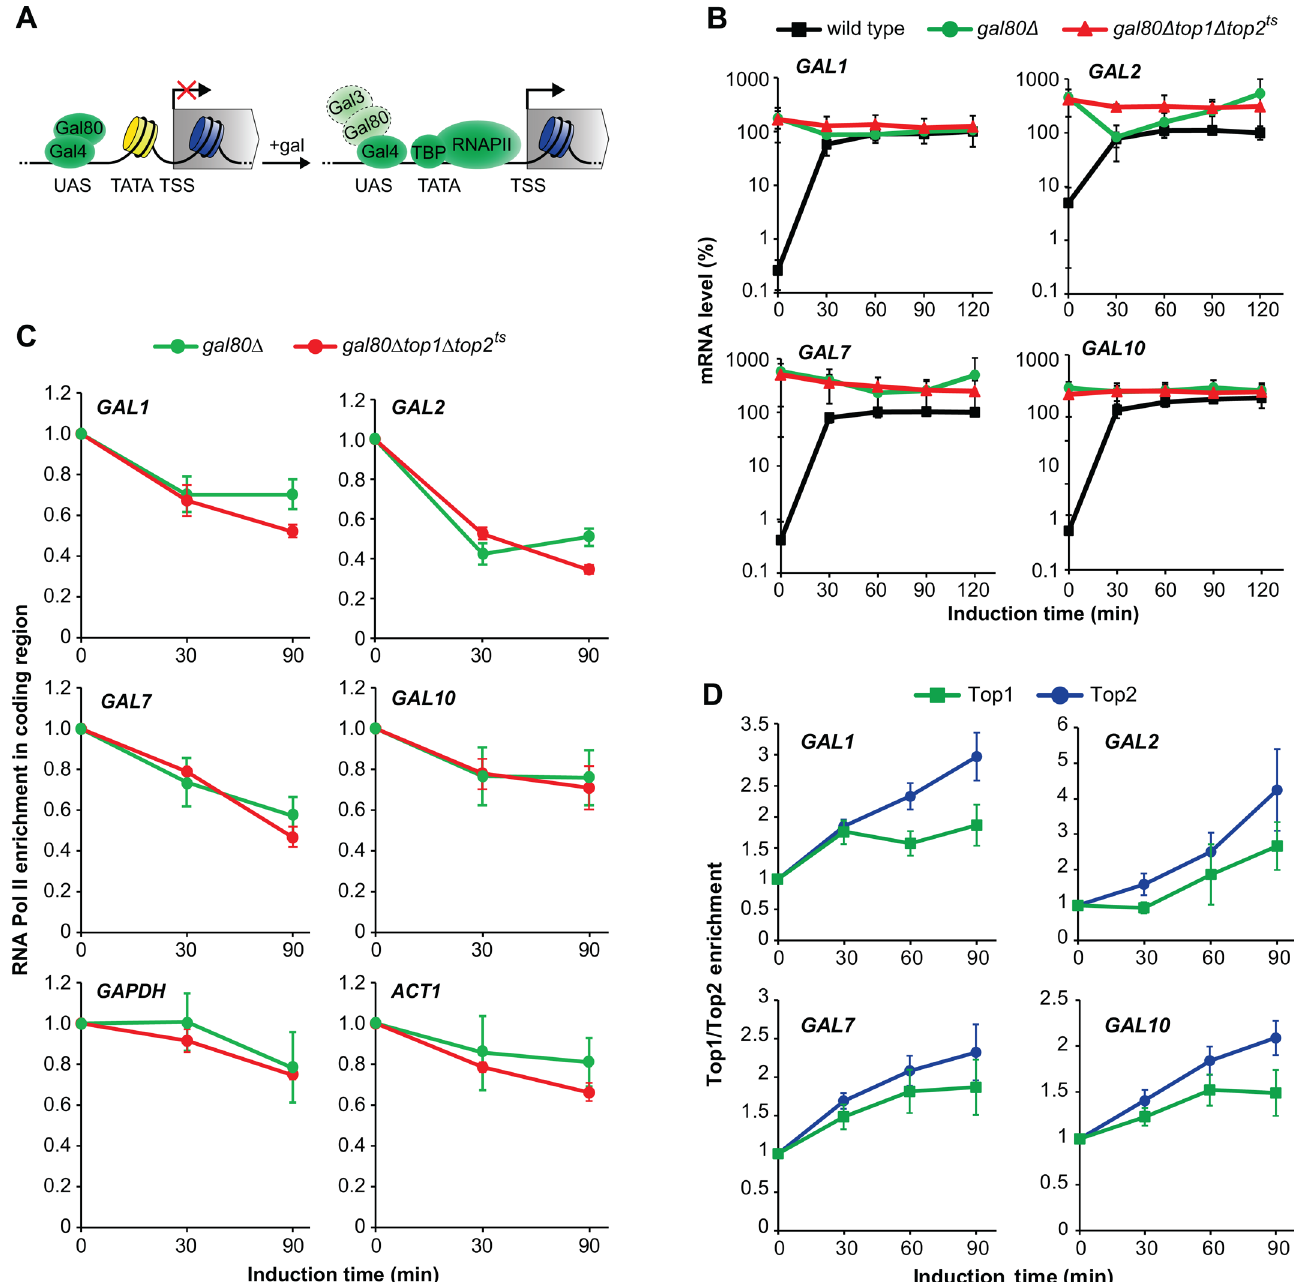
Fig 2. Topoisomerase activity has a direct role in GAL gene activation but is not required for transcriptional elongation and reinitiation. (A) Overview of promoter changes during transcriptional induction of the GAL genes. ( left ) In raffinose, the GAL gene promoter is covered by nucleosomes except at the UAS, which binds Gal4 having its activation domain blocked by Gal80. ( right ) Upon galactose addition, Gal3 binds Gal80, leaving the activation domain of Gal4 free to bind chromatin remodelers. Subsequent removal of promoter nucleosomes allows recruitment of TBP and RNA polymerase II. UAS, Upstream Activating Sequence. TATA, TATA box. TSS, Transcription Start Site. gal, galactose. Light coloring and dashed borders of Gal3 and Gal80 indicate that the enzymes do not block the Gal4 activation domain, either due to dissociation or rearrangement of the complex. (B) Time course experiment of GAL1 , GAL2 , GAL7 , and GAL10 transcription in wild type, gal80 Δ , and gal80 Δ top1 Δ top2 ts cells. Cells were treated as in Fig 1B, and mRNA levels of the individual genes were quantified by qPCR, normalized to the wild type level at the latest time point (set to 100%), and presented on a log10-scale. The average from two individual experiments is shown, and error bars represent ± one standard deviation. (C) Time course experiment with ChIP analysis of RNA polymerase II enrichment in the coding regions of the GAL genes and two control genes, GAPDH and ACTI , following transcriptional activation. Cells were treated as in Fig 1B, and ChIP was performed with antibodies recognizing the C-terminal domain of the Rpb1 subunit of RNA polymerase II. RNA polymerase II binding levels were normalized relative to the binding at the 0 min time point (set to 1). (D) Time course experiment with ChIP analysis of Top1 and Top2